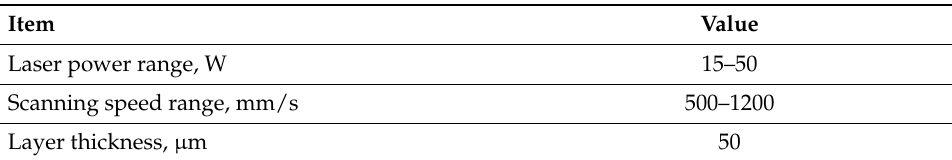
Table 4. CO 2 laser process parameters used in the study.